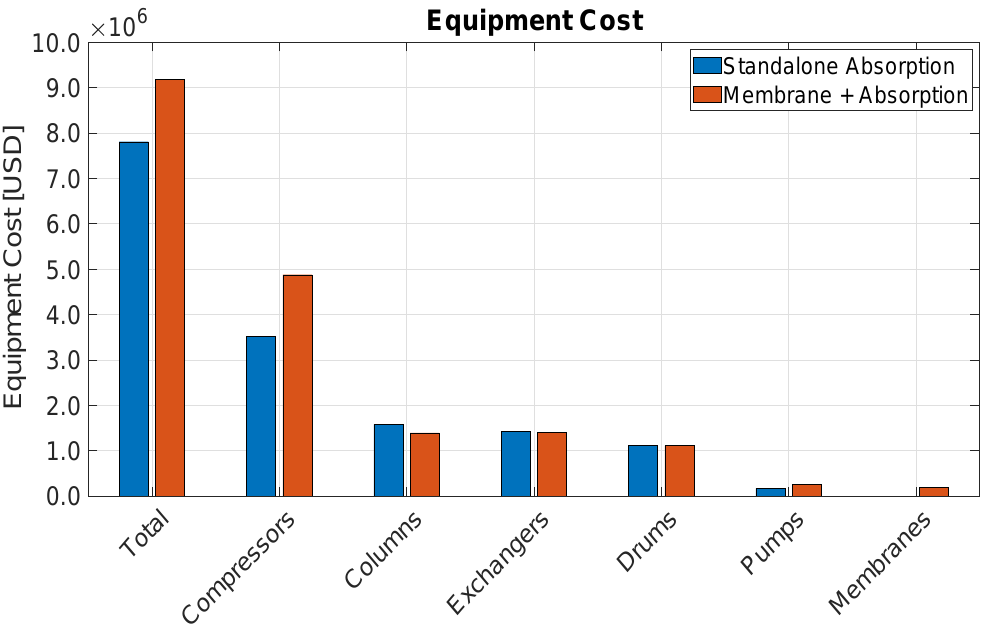
Figure 8. Cost of equipment installed in the CO 2 removal section for the two compared process configurations. Reproduced with permission from Penteado, Ph.D. Thesis, TUB, 2021